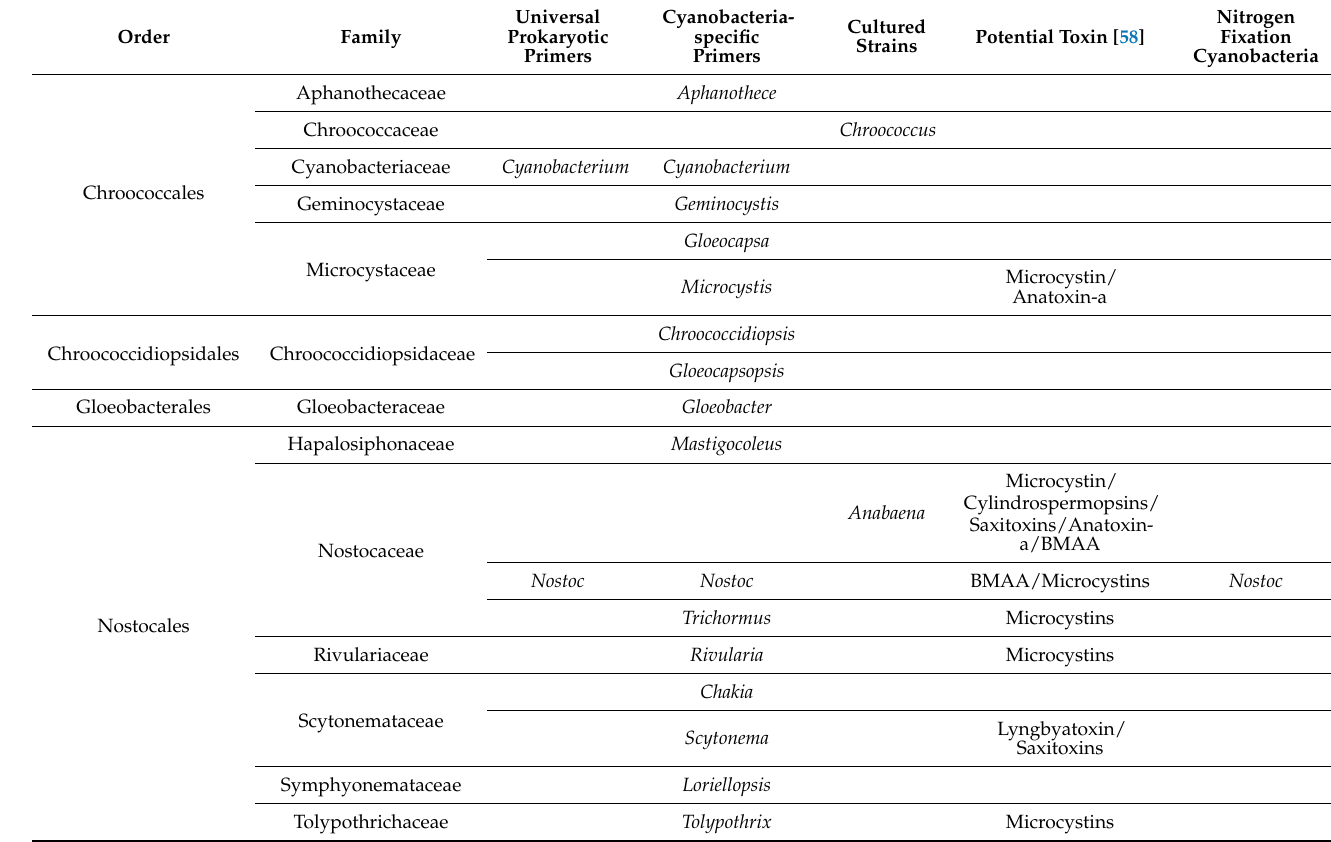
Table 1. List of cyanobacterial genera based on universal and cyanobacteria-specific 16S rRNA gene primer metabarcording, as well as morphotypes observed in the present study, including potential toxic and nitrogen-fixing